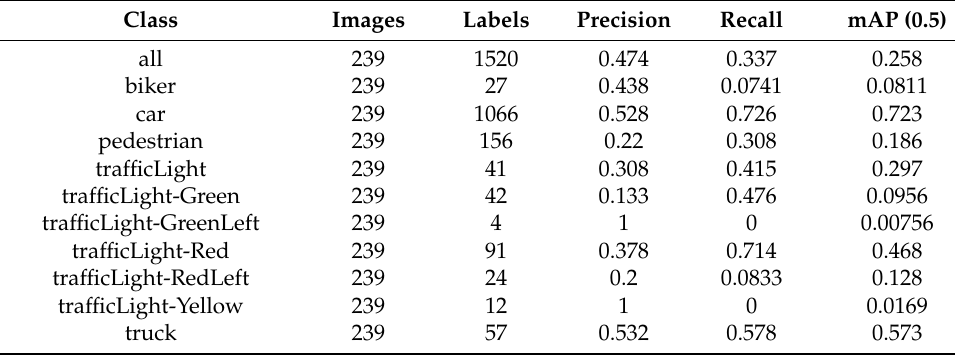
Table 2. Performance of the model YOLOv5s for custom Roboflow data. Class Images Labels